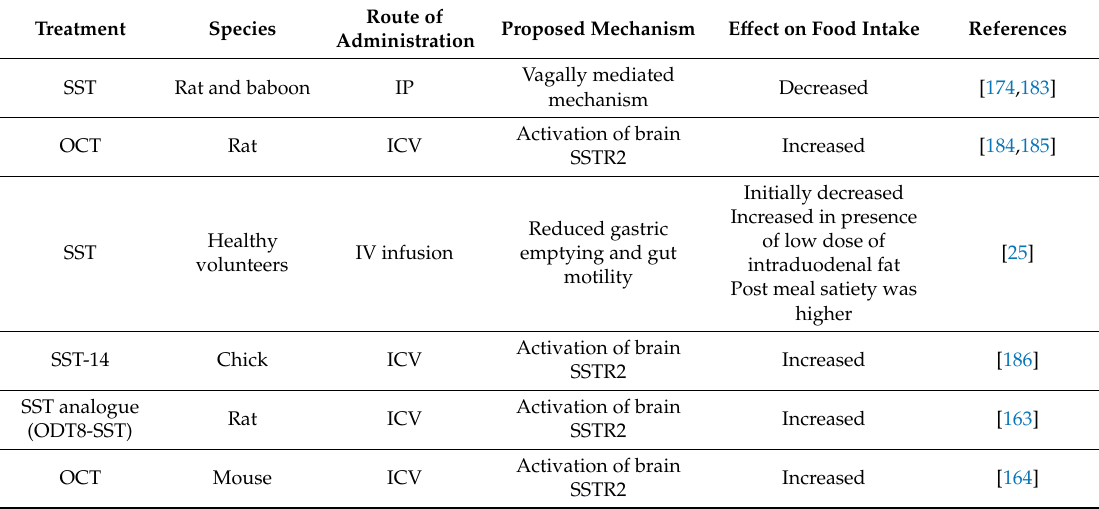
Table 2. Summary of studies for the e ff ect of SST analogues and receptor subtype on food intake. Route of Proposed Mechanism E ff ect on Food Treatment Species Administration